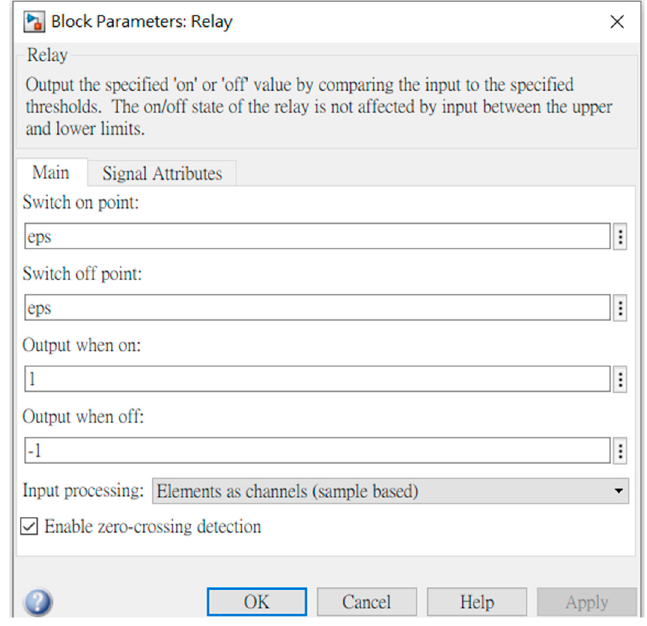
Figure 5. Parameter setting for relay block.